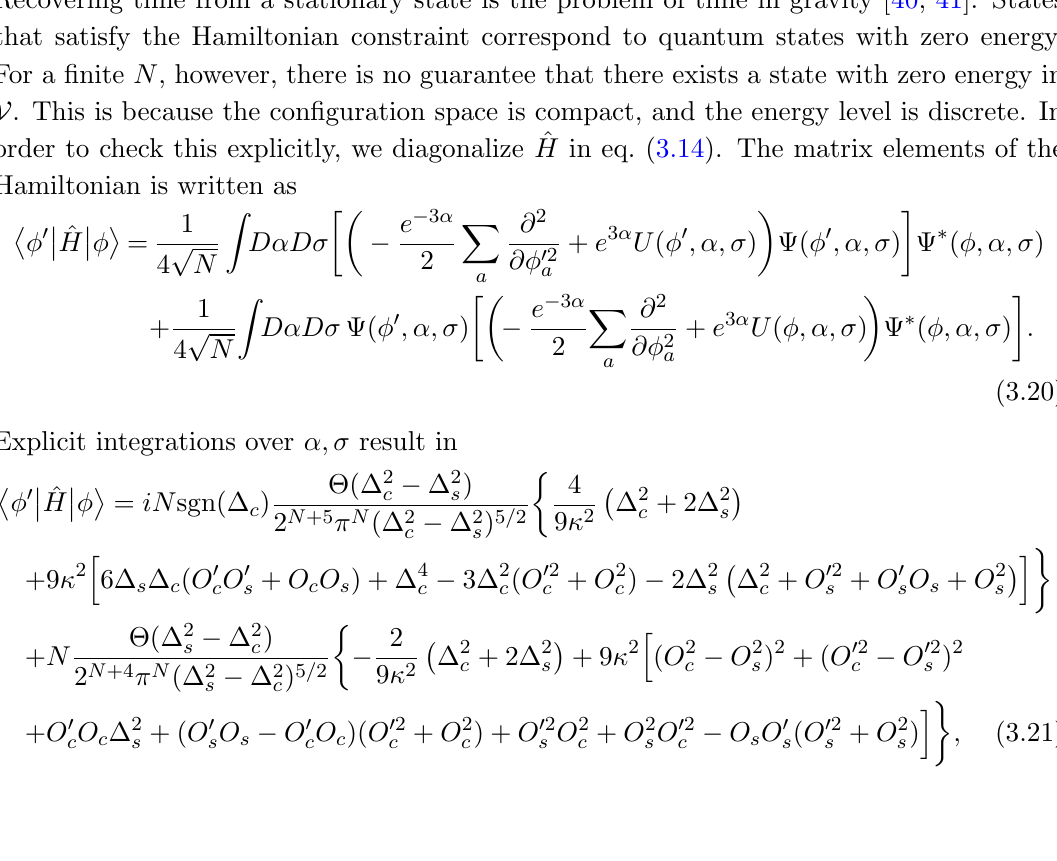
Figure 4 . The (cid:12)lled box represents an operator that acts on a quantum state of the matter (cid:12)eld, (cid:12) (cid:12) (cid:11) (cid:11) = R d(cid:11)d(cid:27) (cid:31) ( (cid:11); (cid:27) ). If the operator is an endomorphism of V , it can be represented as an (cid:12) (cid:31) (cid:12) (cid:11); (cid:27) operator (represented by the empty box) that acts on the wavefunction (cid:31) ( (cid:11); (cid:27) ) for the collective